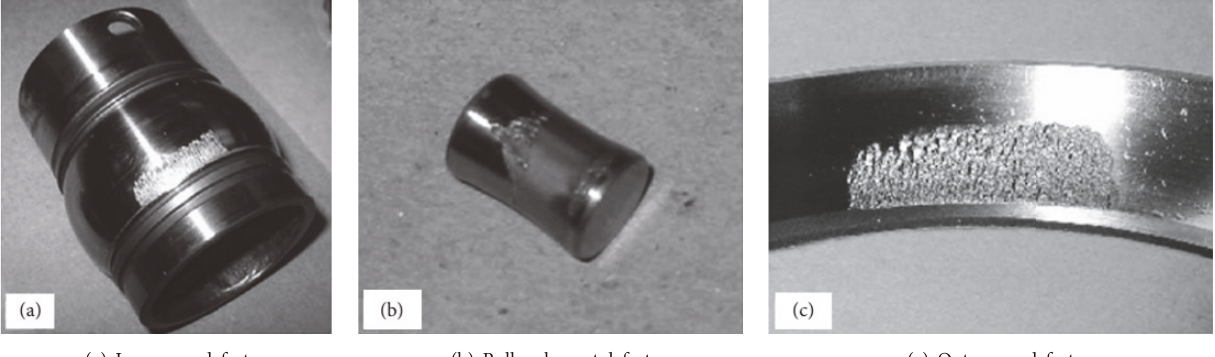
Figure 4: Components of failure